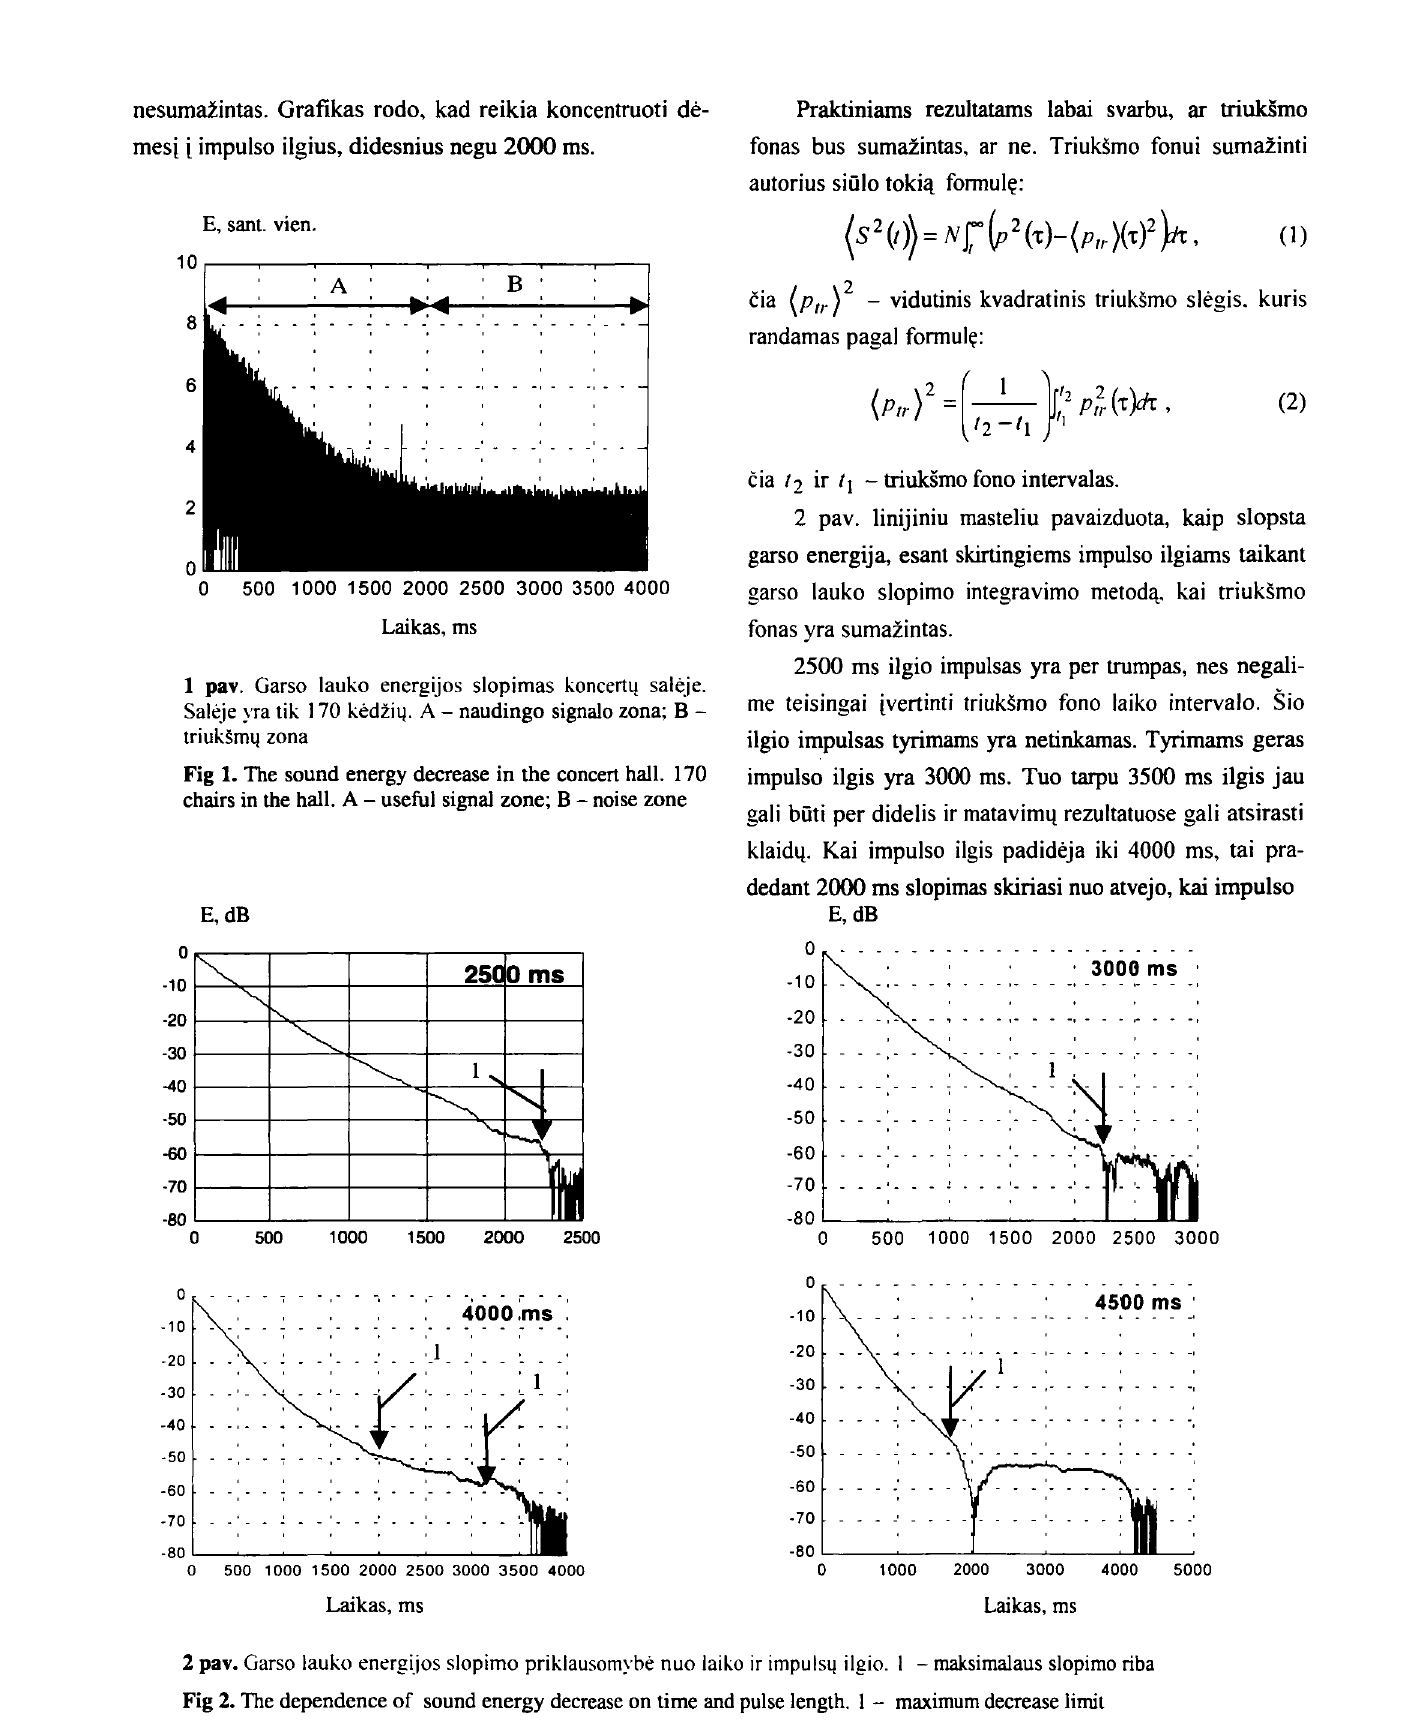
1 pav. Garso lauko energijos slopimas koncert4 saleje. Saleje yra tik 170 kedzi4. A- naudingo signalo zona; B - triuksm4 zona Fig 1. The sound energy decrease in the concert hall. 1 70 chairs in the hall. A - useful signal zone; B - noise zone